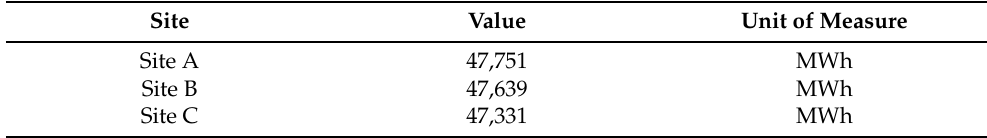
Table 11. Annual energy production from Global Solar